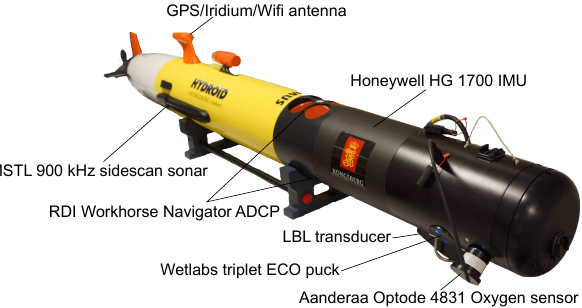
Figure 6: The NTNU REMUS 100 AUV.